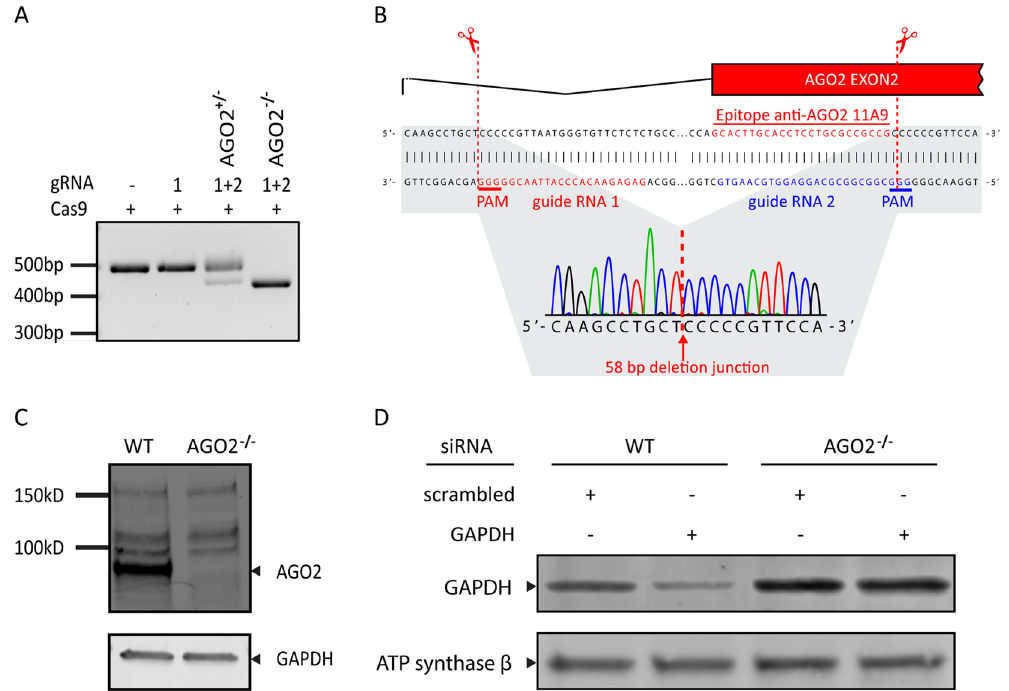
Figure 4. AGO2 11A9 antibody validation with CRISPR/Cas9 introduced AGO2 knock-out. ( A ) Agarose gel showing the genotyping PCR products amplified from the CRISPR/Cas9 targeted region. ( B ) Overview figure displaying the deletion by CRISPR/Cas9 determined with Sanger sequencing. The AGO2 exon2 bar corresponds with the underlying sequence and in red the sequence encoding the epitope of anti-AGO2 11A9. ( C ) AGO2 11A9 stained Western blot loaded with whole cell lysates from wild type and AGO2 knock-out HEK293T cells. GAPDH was stained as loading control. ( D ) Western blot of siRNA treated wild-type and AGO2 knock- out HEK293T extracts. ATP synthase- β was used as a loading control. Uncropped images are shown in the